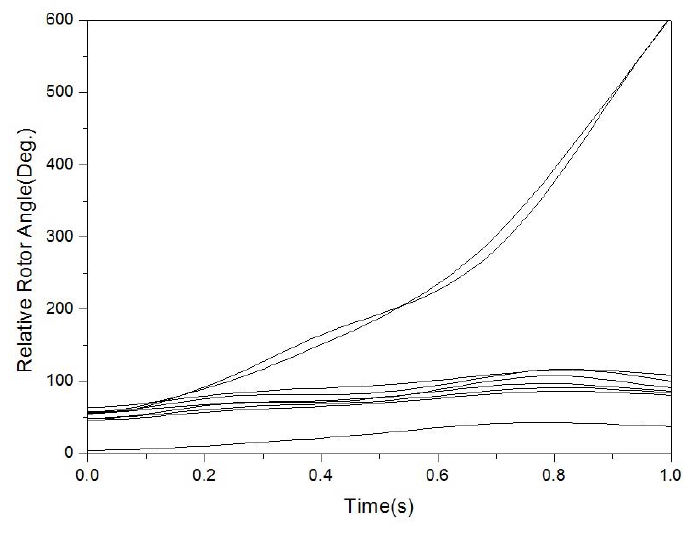
Figure 6. Post-fault rotor angle